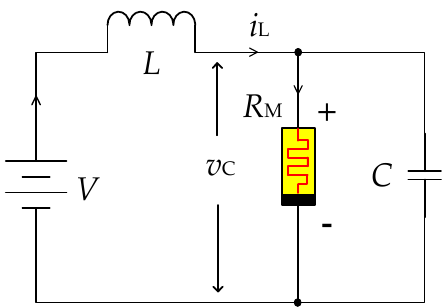
Figure 16. Chaotic oscillation circuit.